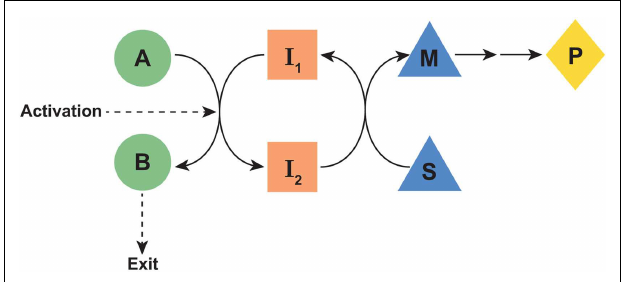
FIGURE 1 | Schematic of proposed parametabolic regulation. The A-B pathway is in a metabolic interlock with the S-M pathway. Genetic or epigenetic upregulation of the A-B pathway would result in an increased production of P.The designated symbols are generic. However, in the context of the proline regulatory axis, A-B would represent the glutamine to proline pathway, I 1 , and I 2 would be pyridine nucleotides, the S-M pathway would represent the oxidative arm of the pentose phosphate pathway and P would be PP-ribose-P. “Exit” may be either excretion, incorporation into protein, or another mechanism for departure from the parametabolic regulatory